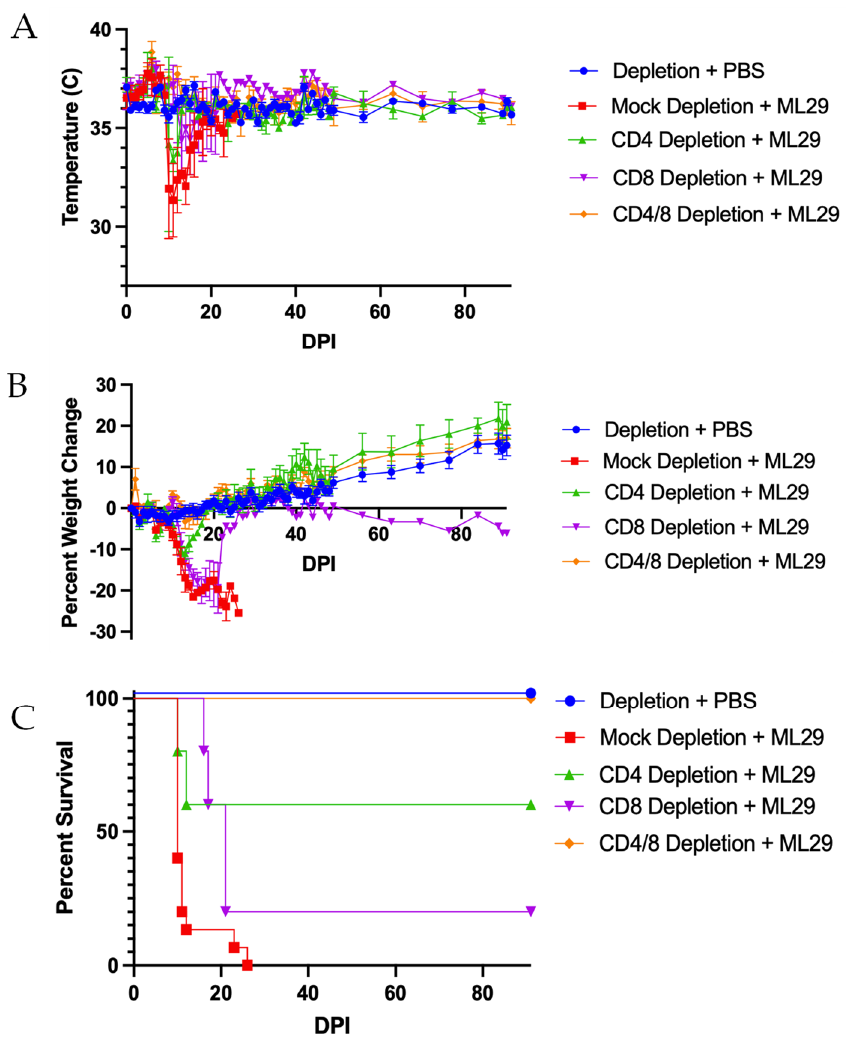
Figure 5. Both CD4 and CD8 T cells are responsible for acute disease in ML29 infection. STAT1-/- mice were depleted of either or both CD4 and CD8 T cells and inoculated with ML29 or PBS as a mock control. ( A ) Changes in body temperature post-infection. ( B ) Changes in body weight post-infection. ( C ) Percent survival. n = 10 Depletion + PBS; n = 15 Mock Depletion + ML29; n = 5 CD4 Depletion + ML29, CD8 Depletion + ML29 in panels ( B , C ), and CD4/8 Depletion + ML29; n = 4 CD4 Depletion ML29 in panel ( A ).